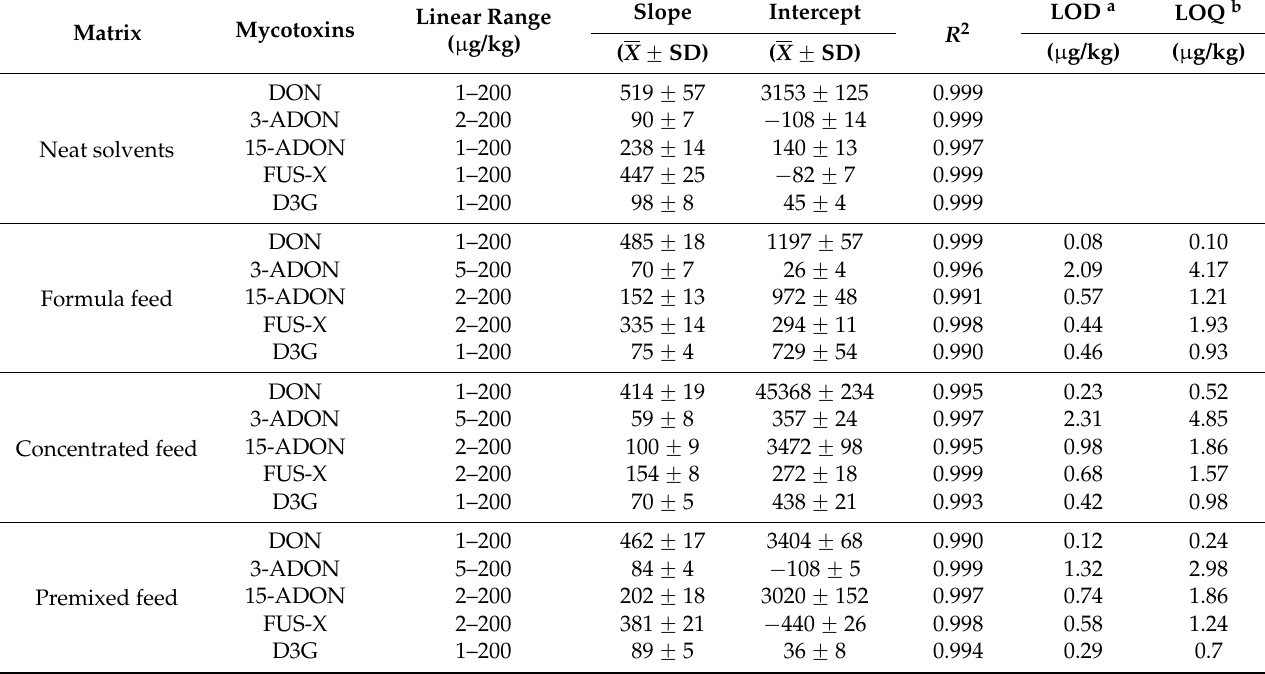
Table 1. Calibration curves and sensitivities of five targeted mycotoxins in neat solvents and various feed products, respectively.